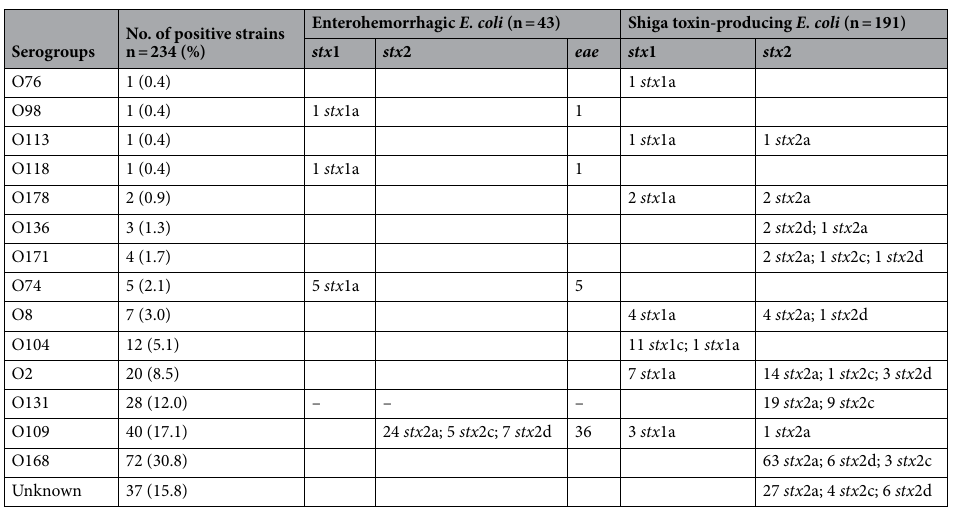
Table 2. Detection of serogroups, virulence genes, and Shiga toxin gene subtypes in Shiga toxin-producing Escherichia coli strains (n = 234) isolated from cattle feces from eight commercial feedlots by multiplex PCR assays (2014 study).